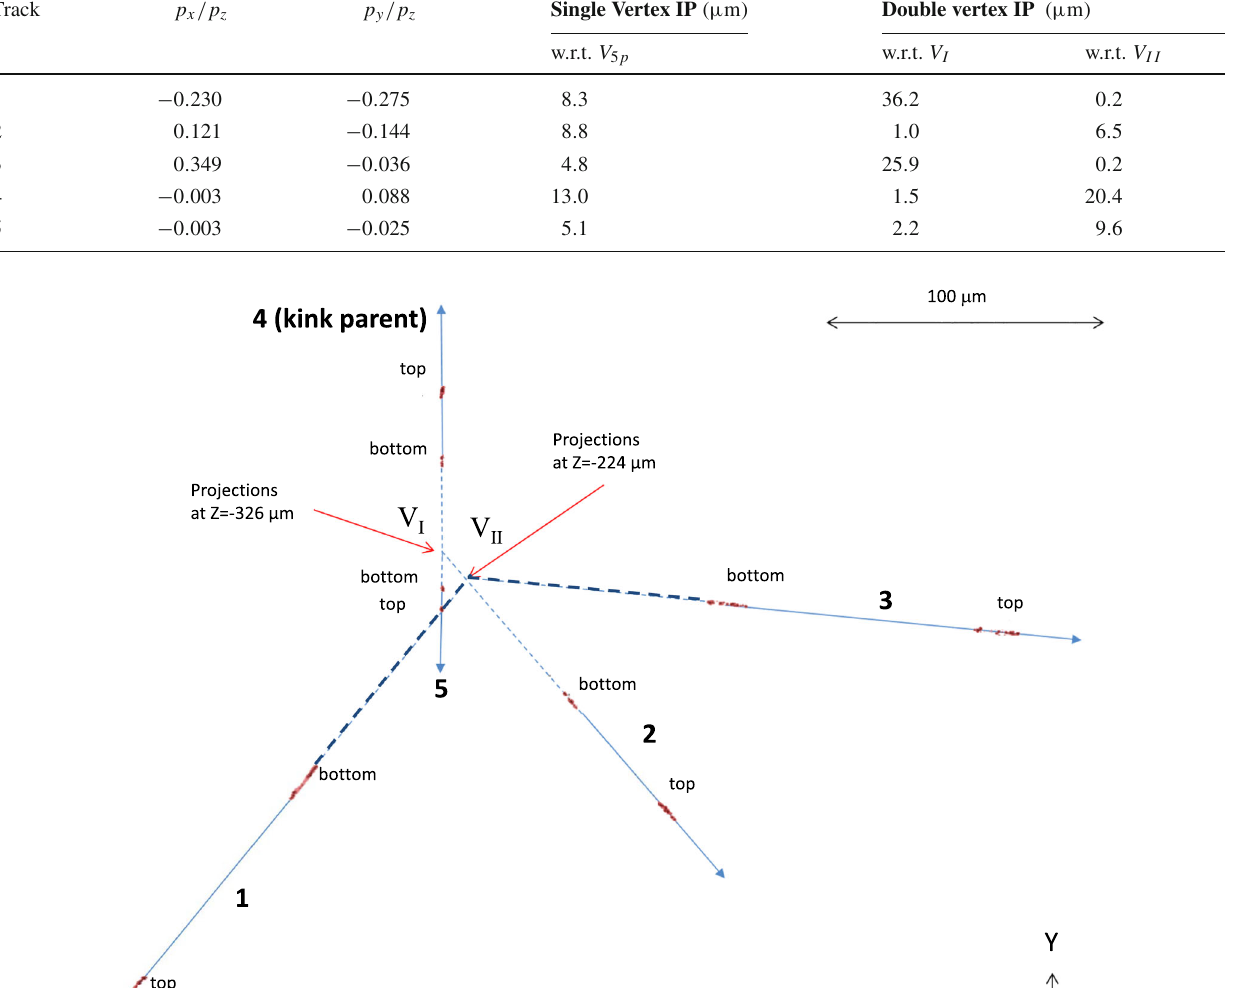
order of 0.6 µ m. The interaction is located well inside the brick. The coordinates of vertices V I and V II are reported in Table 2